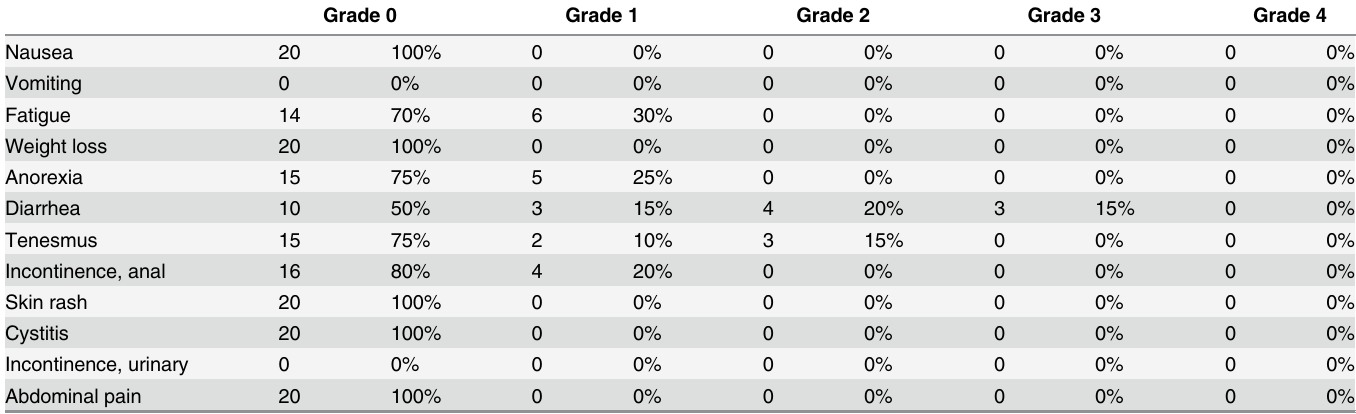
Table 3. Prospective evaluation of late toxicity (n = 20).